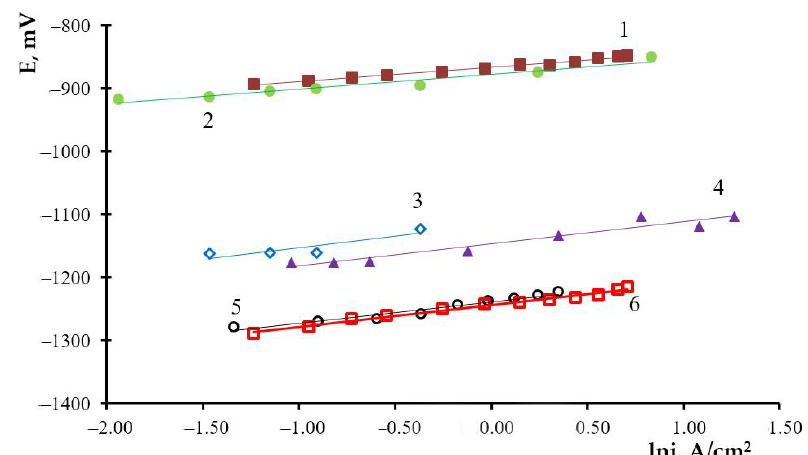
Figure 2. Straight line regions of lead, bismuth and Pb–Bi alloys polarization in the KCl–PbCl 2 (50–50 mol.%) melt at 773 K, mol.%: 1—Bi; 2—Pb–Bi (3.0–97.0); 3—Pb–Bi (5.0–95.0); 4—Pb–Bi (7.0–93.0); 5—Pb–Bi (59.3–40.7); 6—Pb. Table 2. Equations of lines and number of electrons, calculated according to the angular coefficient at 823 K.